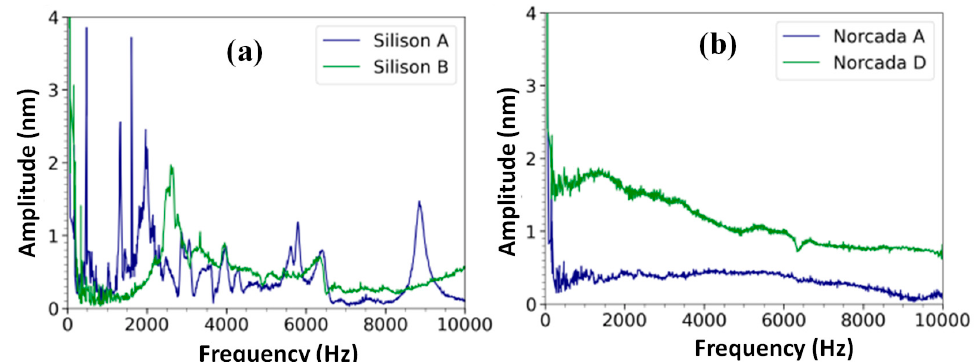
Figure 5. The frequency response of four different membranes measured at the center of the mem- brane is shown. ( a ) The spectra of Silison A and B membranes mounted on the washer plate. ( b ) The spectra of two Norcada membranes mounted on the o-ring. The piezo was used to generate a chirp pattern with a duration of 100 s at an amplitude of 10 Vpp. The distance from the piezo to the membrane was set at approximately 5